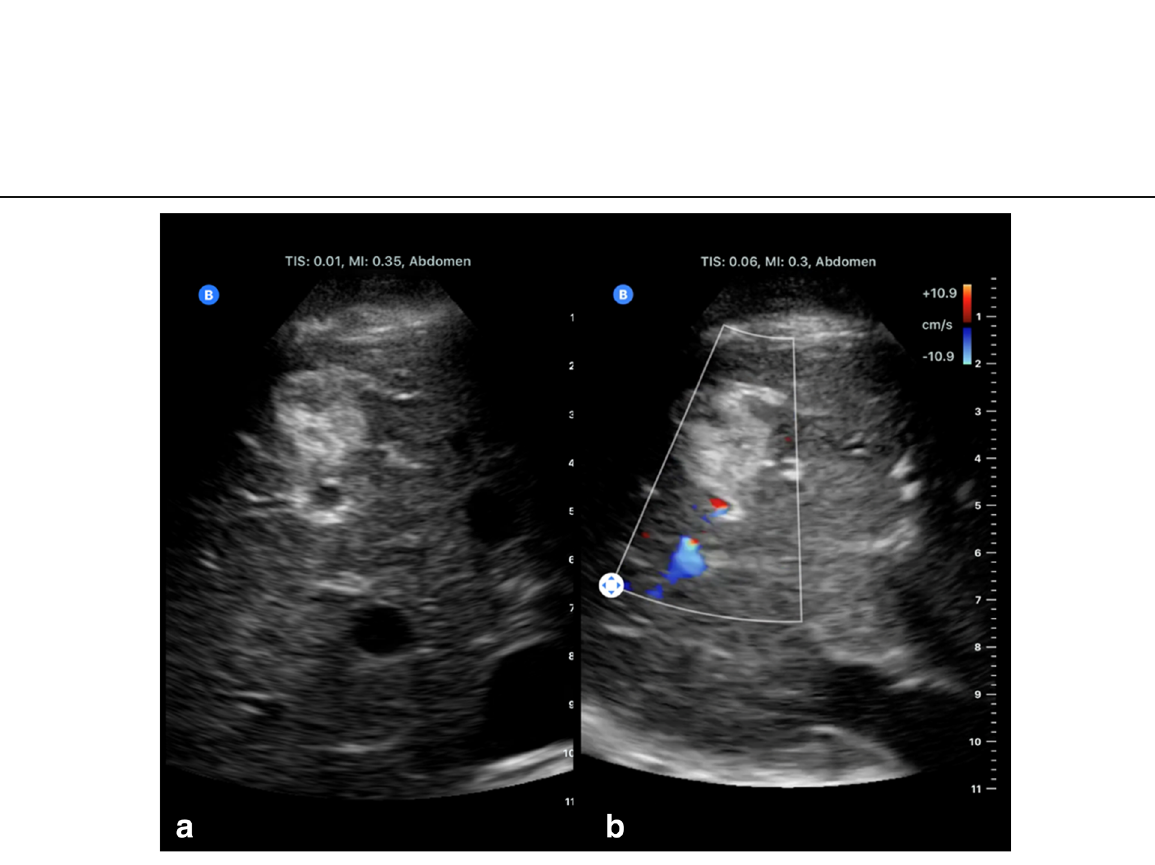
Fig. 9 Butterfly ’ s iQ emulate curved transducers: B-scan ultrasound ( a ) and colour Doppler ( b ) of a liver